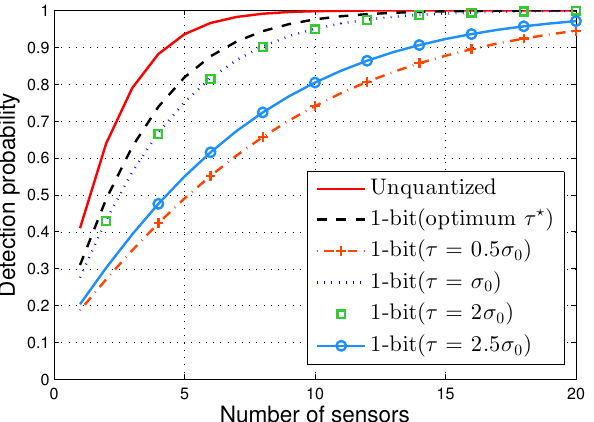
Figure 3. Performance the proposed one-bit GLRT detector with several choices of the threshold τ and the unquantized detector, when P